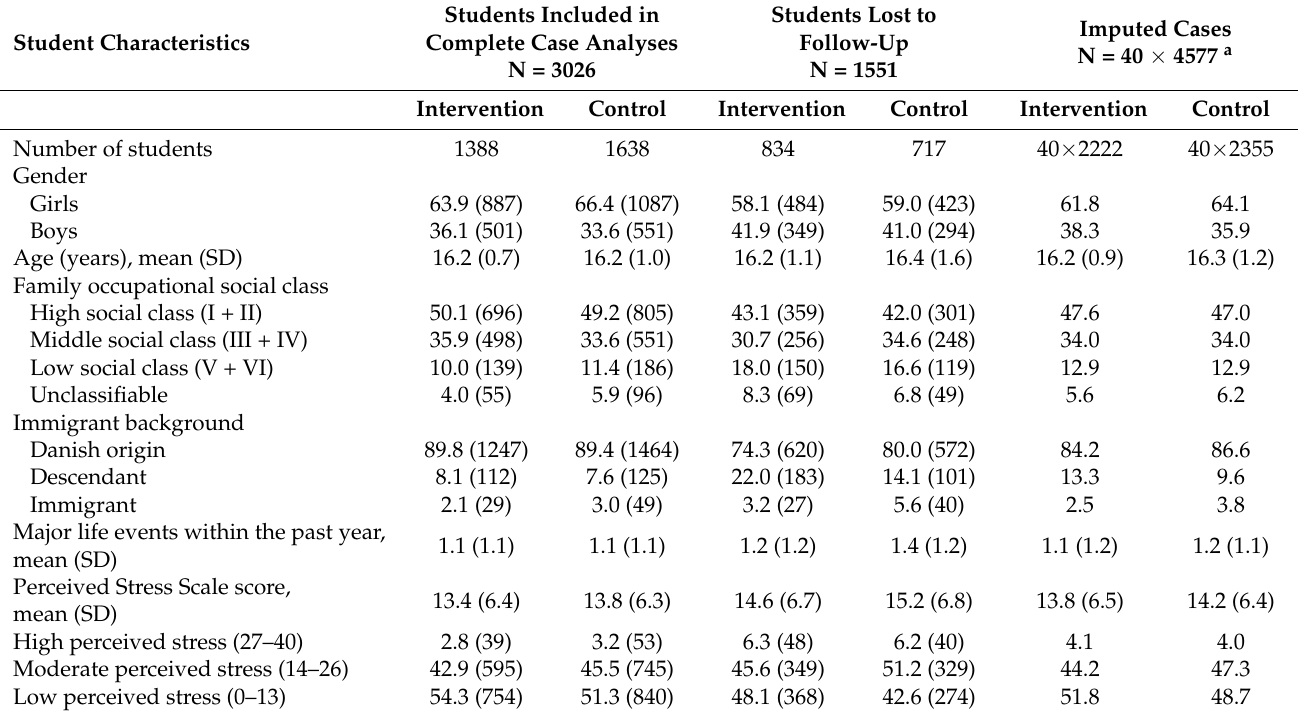
Table 2. Baseline characteristics of students participating in baseline, those lost to follow-up, and imputed cases. Values are percentages followed by numbers in parentheses unless stated